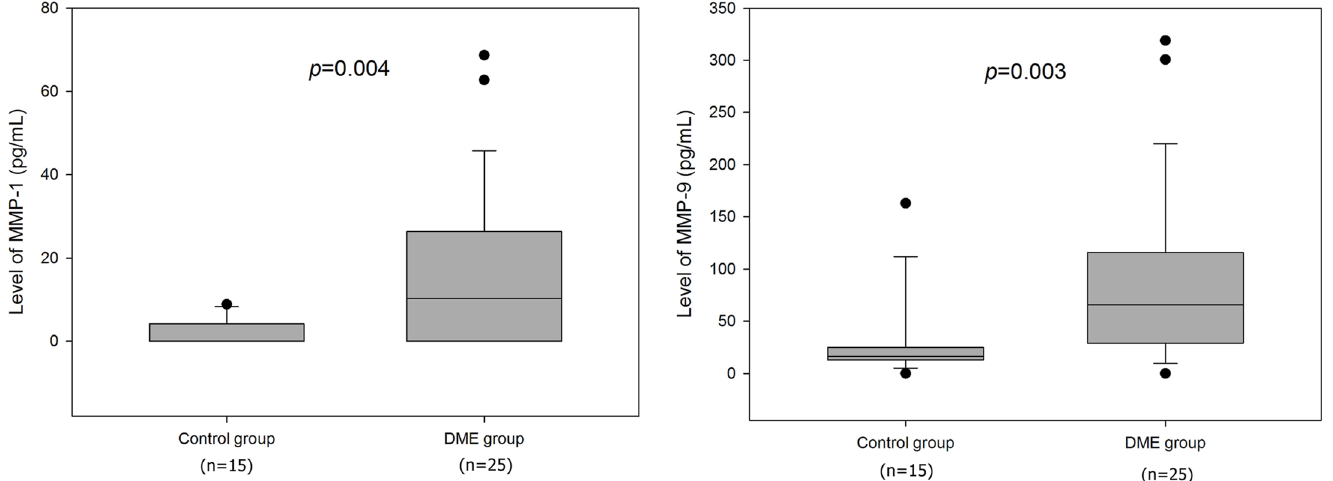
Fig 1. The box and whisker plots for levels of metalloproteinases (MMPs). The bottom and top of the box are the first and third quartiles with a line to show the median value. The whiskers show the 10 th and 90 th percentiles. Circles represent outliers. The levels of MMP-1 and MMP-9 are increased in diabetic macular edema (DME) group with significant